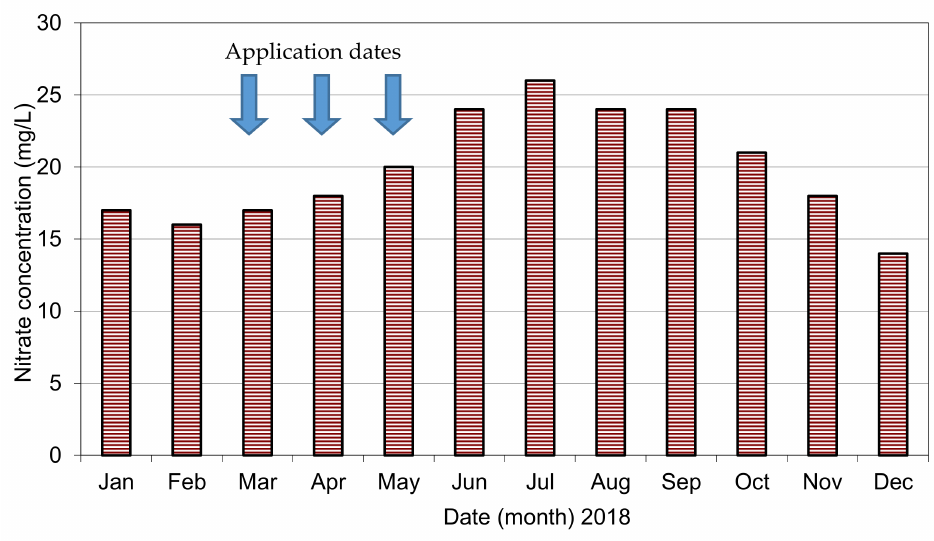
Figure 4. Nitrate values in the wellfield groundwater and dates of fertilizer